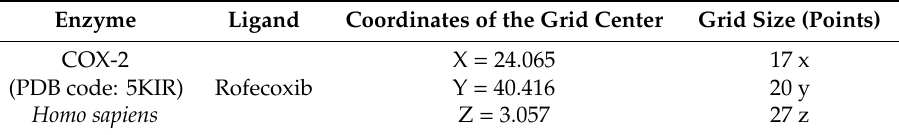
Table 10. Protocol data used in the validation of molecular